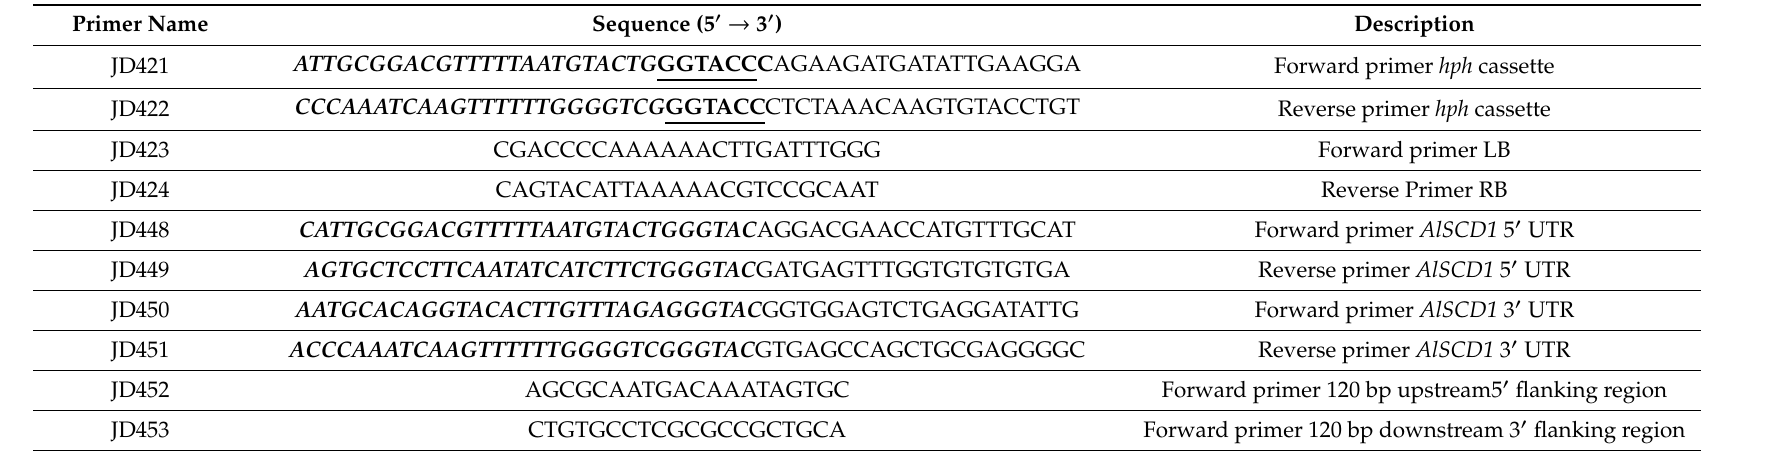
Table 1. Primer sequences used in this